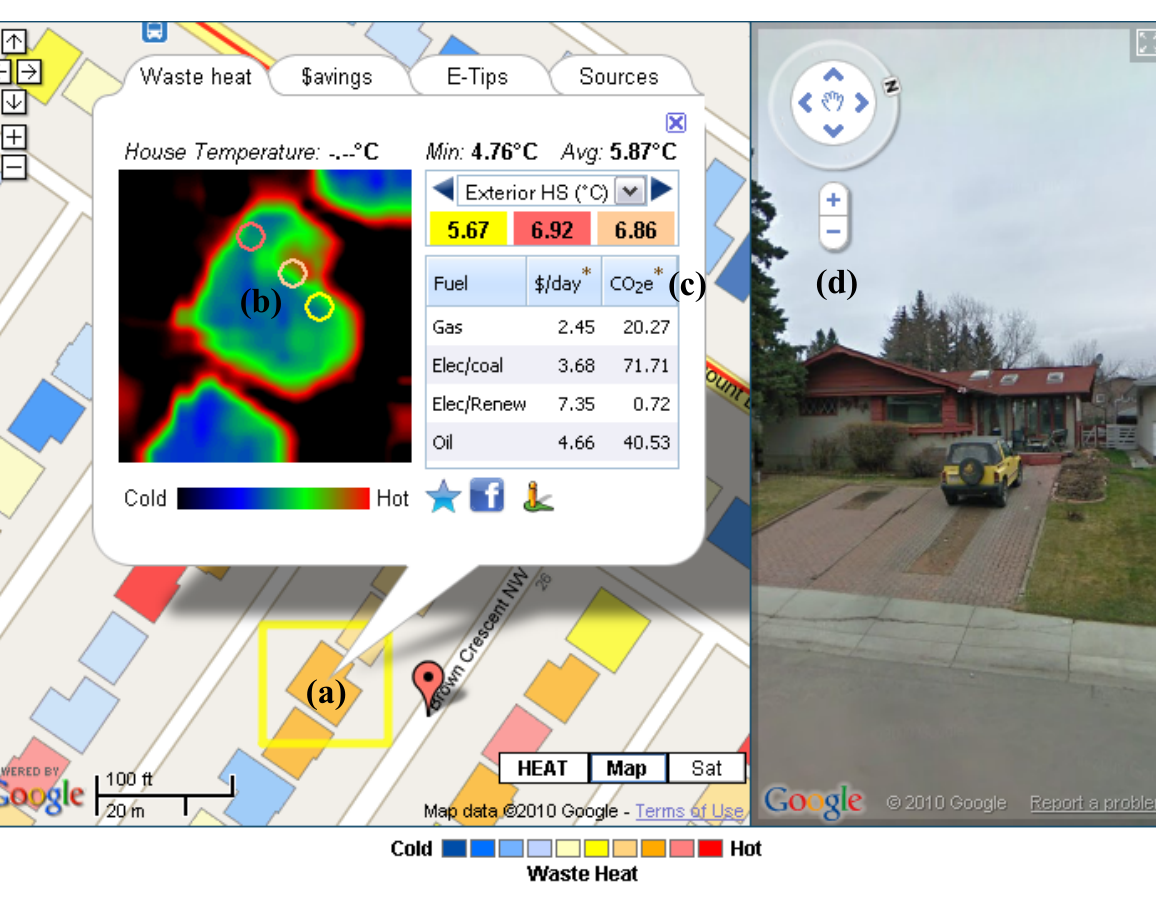
Figure 5. This screen-capture from the HEAT (Home Energy Assessment Technologies) GeoWeb interface [102] shows (a) the community waste heat map which represents the average rooftop temperature of individual homes (colored polygons) classified into 10 temperature classes; (b) Illustrates a colorized heat signature for an individual home, and shows three hot-spots ( i.e ., hottest locations) within the roof envelope (inset colored circles); (c) Shows the Fuel Table which provides the cost of heating the home per